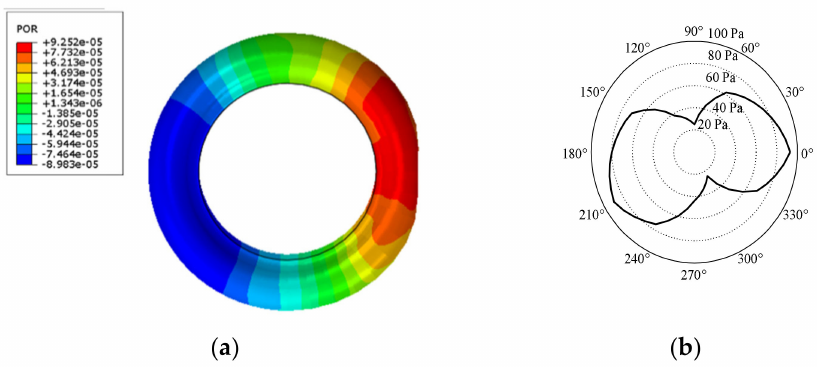
Figure 20. The acoustic pressure amplitude distribution for the running speed of 60 km/h: ( a ) Distri- butions contour of the acoustic pressure amplitude; ( b ) The acoustic pressure amplitude distributions in the polar